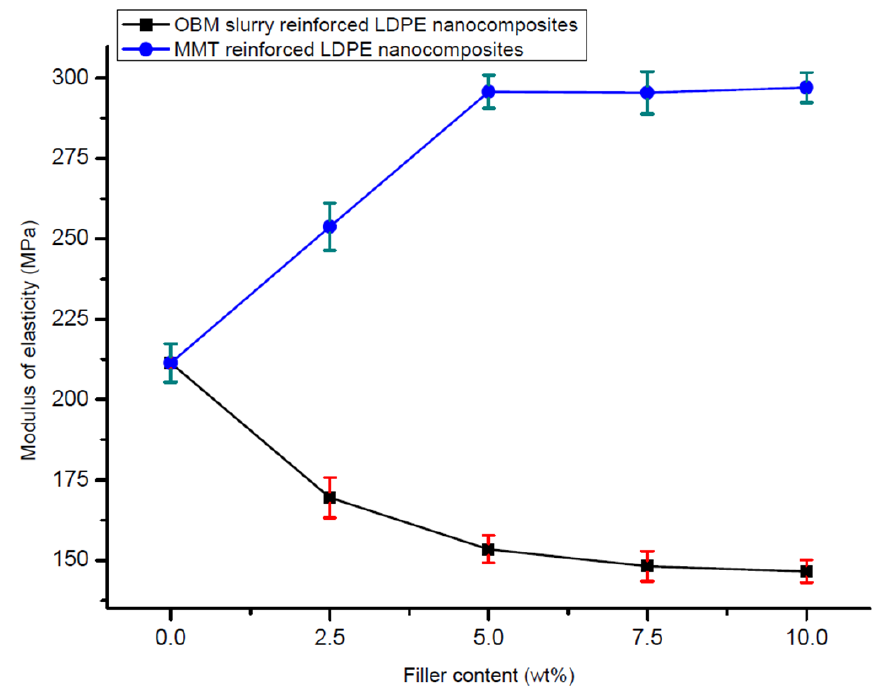
Figure 10. Comparison of modulus of elasticity in tension of neat LDPE, LDPE/MMT and LDPE/OBM slurry nanocomposites.